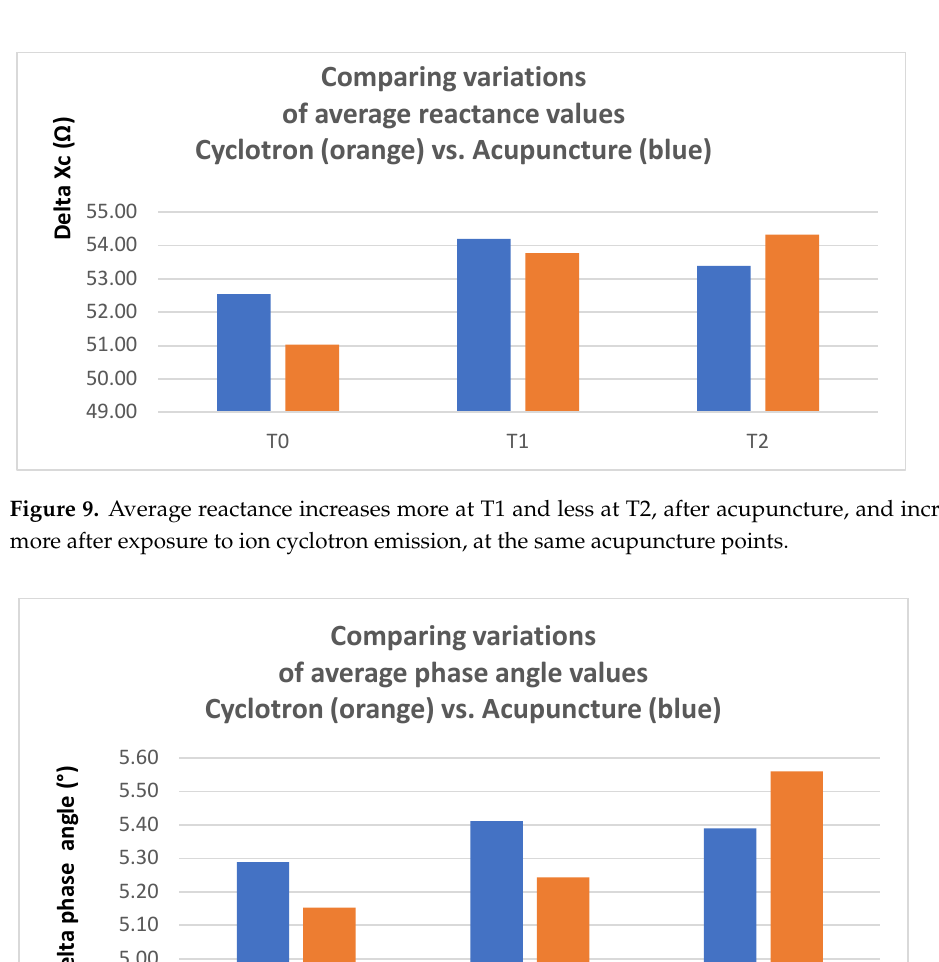
Figure 8. Trends of the average resistance are the same after acupuncture and after exposures to ion cyclotron emission, compared at the same acupuncture points.